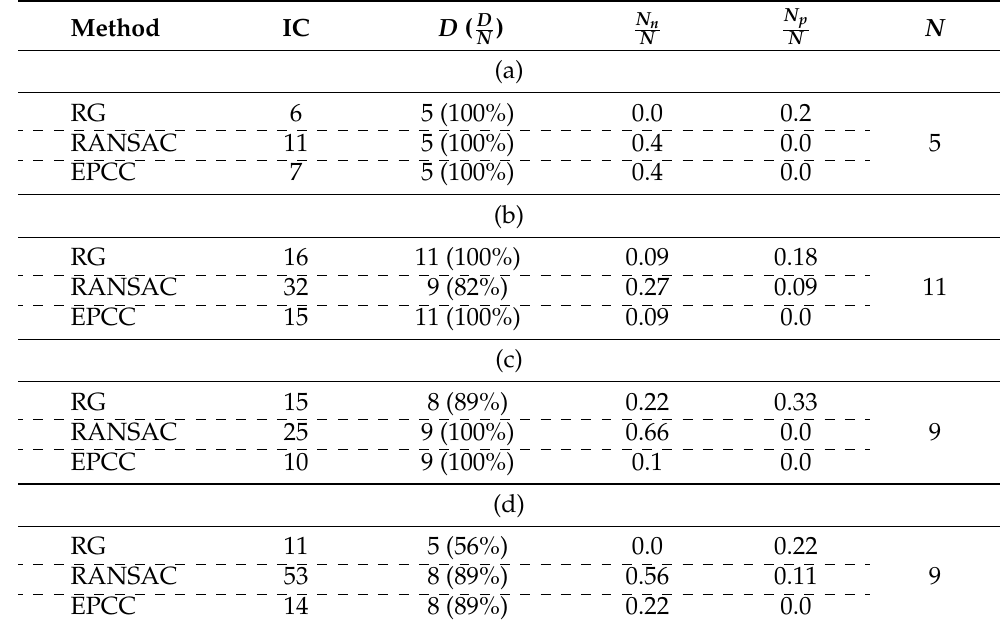
Table 4. Segmentation